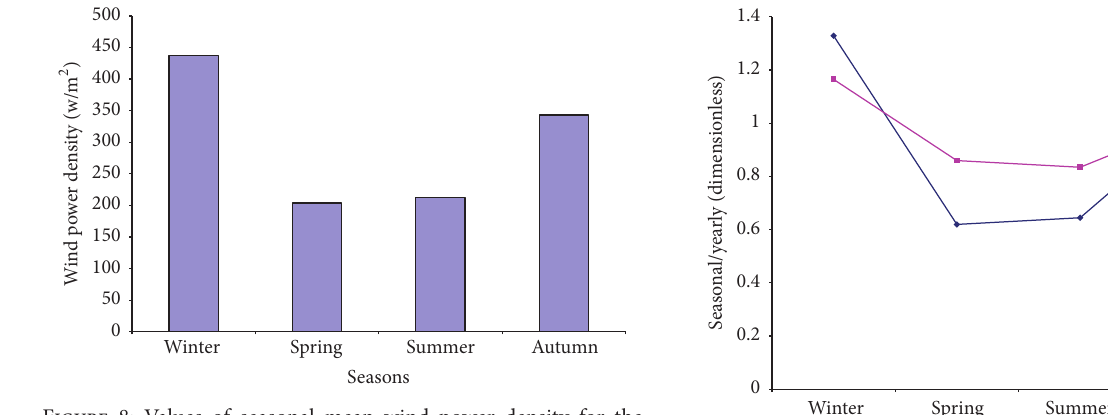
for grid-connected electricity production but might